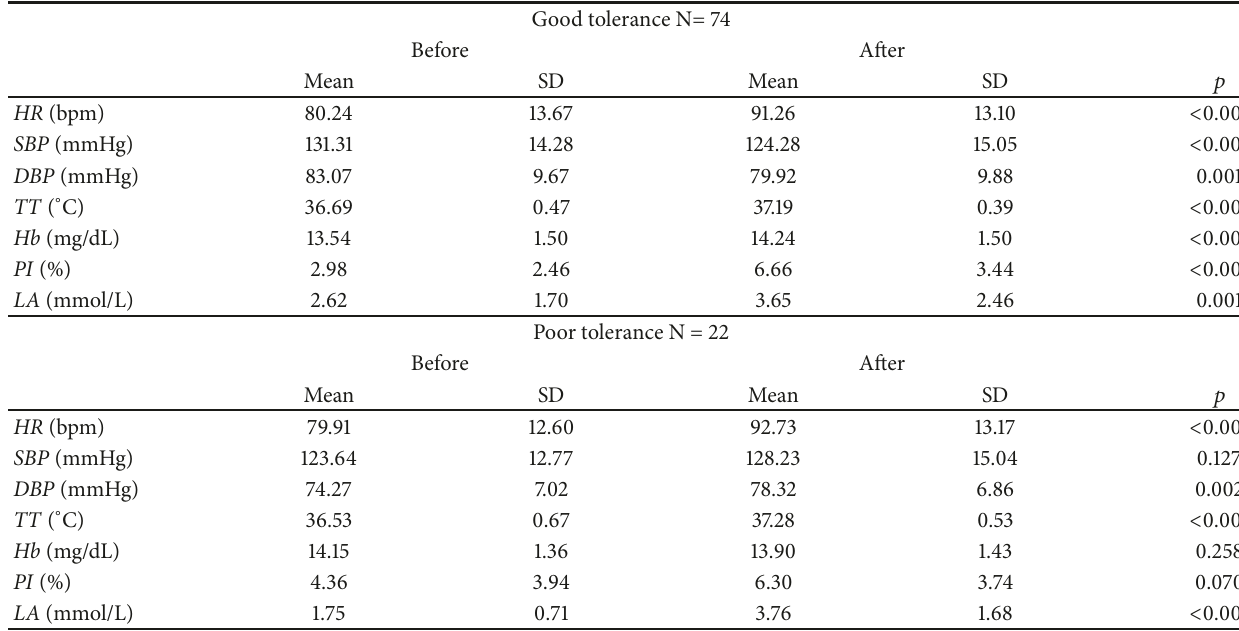
Table 3: Distribution of vital signs before/after by physiological